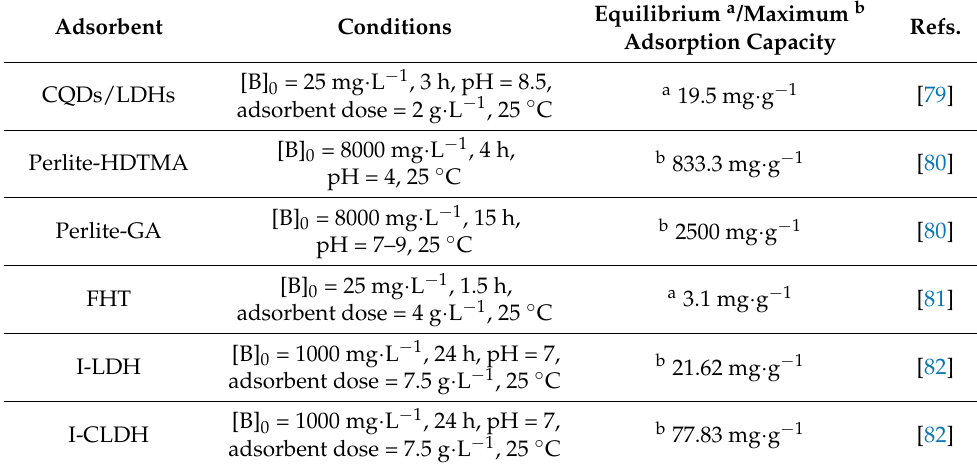
Table 10. Boron removal performance of LDHs